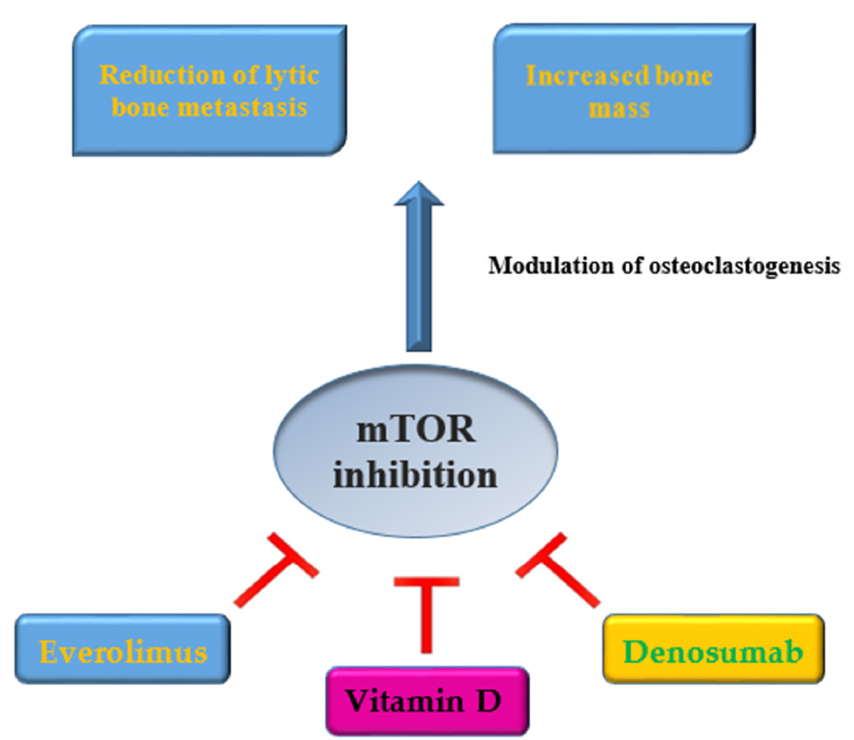
Figure 4. Inhibition of mTOR in cancer and bone effects: Everolimus, Vitamin D and Denosumab together contribute to inhibiting cancer progression and modulate osteoclastogenesis.